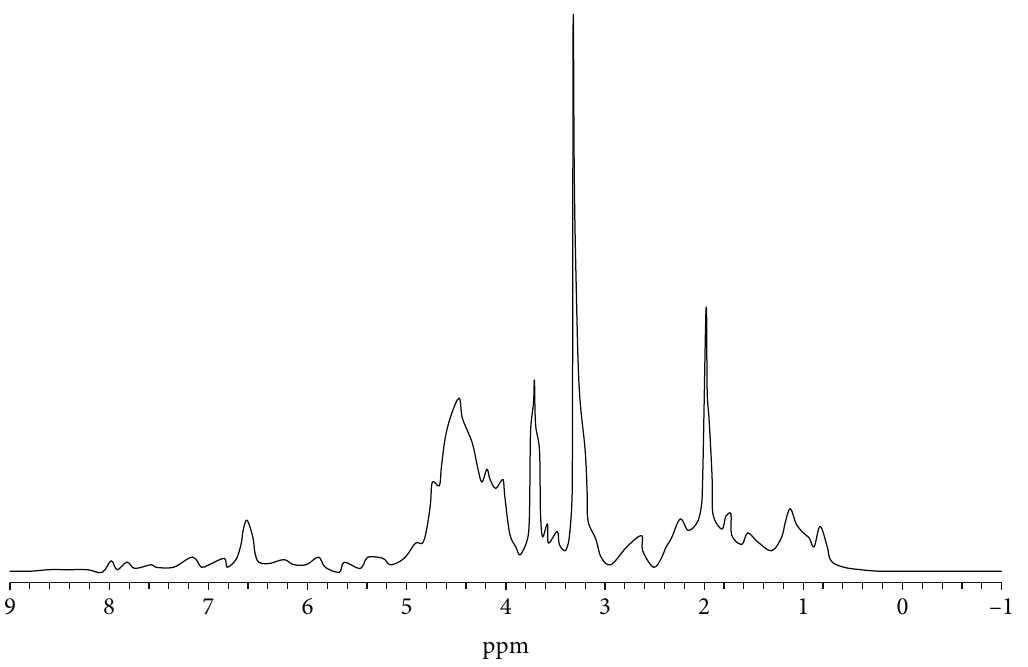
Figure 9: 1 H NMR of the bio-oil obtained from hardwood +